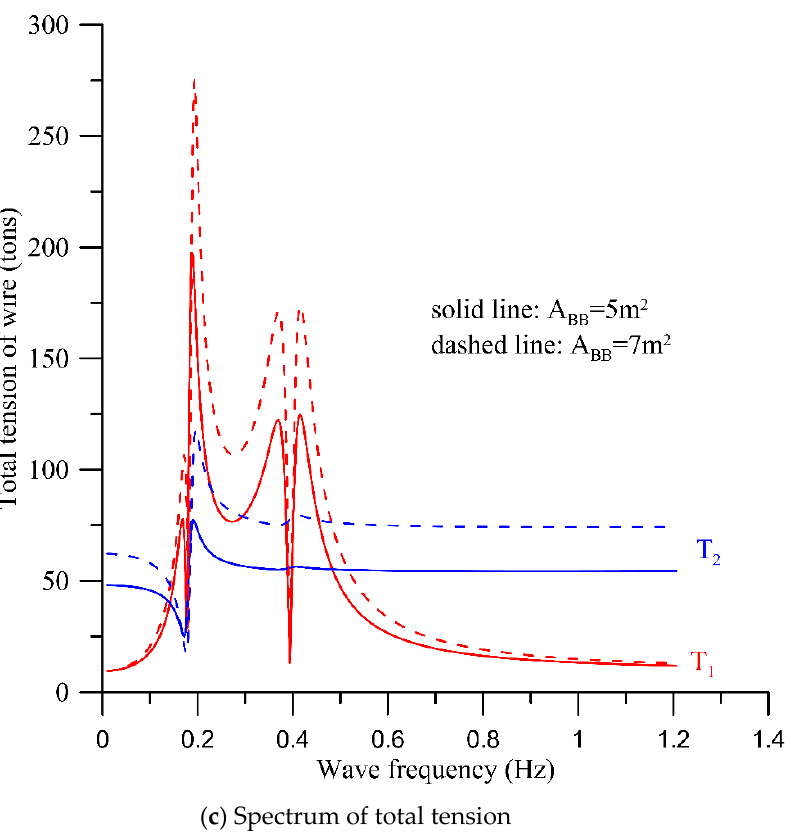
Figure 5. Effects of the cross-sectional area of the pontoon, A BB , and the wave frequency f on the dynamic response of the system including ( a ) dynamic displacements { x 1 d , x 2 d , y 1 d } , ( b ) dynamic tensions of rope, { T 1 d , T 2 d } , ( c ) total tensions of rope, { T 1 , T 2 } . [ M 2 = 5tons, other parameters are the same as those in Figure 4].